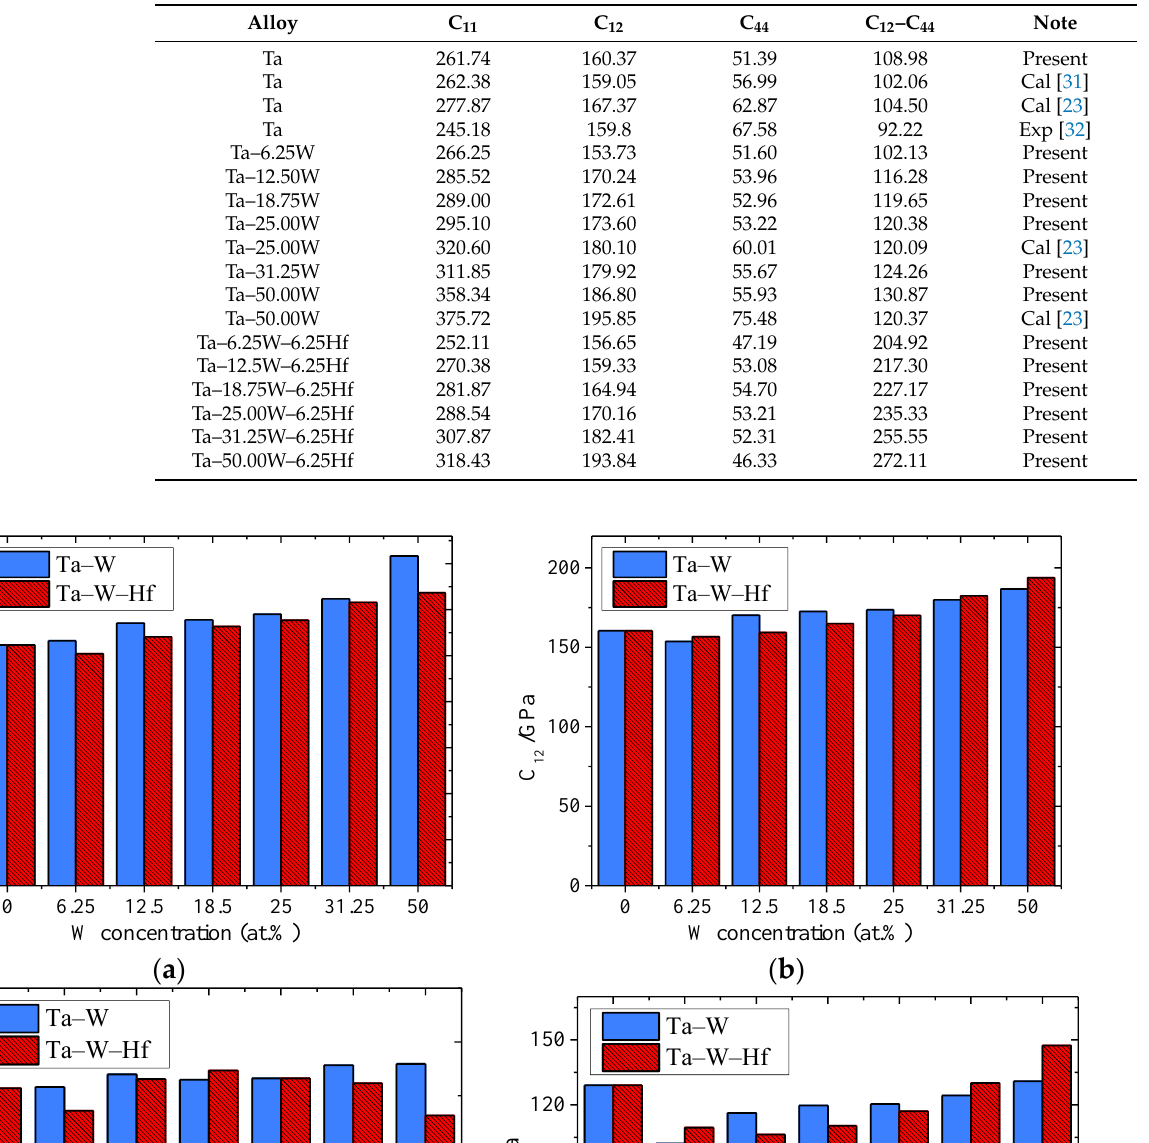
Table 3. The calculated elastic constant of Ta–W alloys with different W content (unit: GPa).